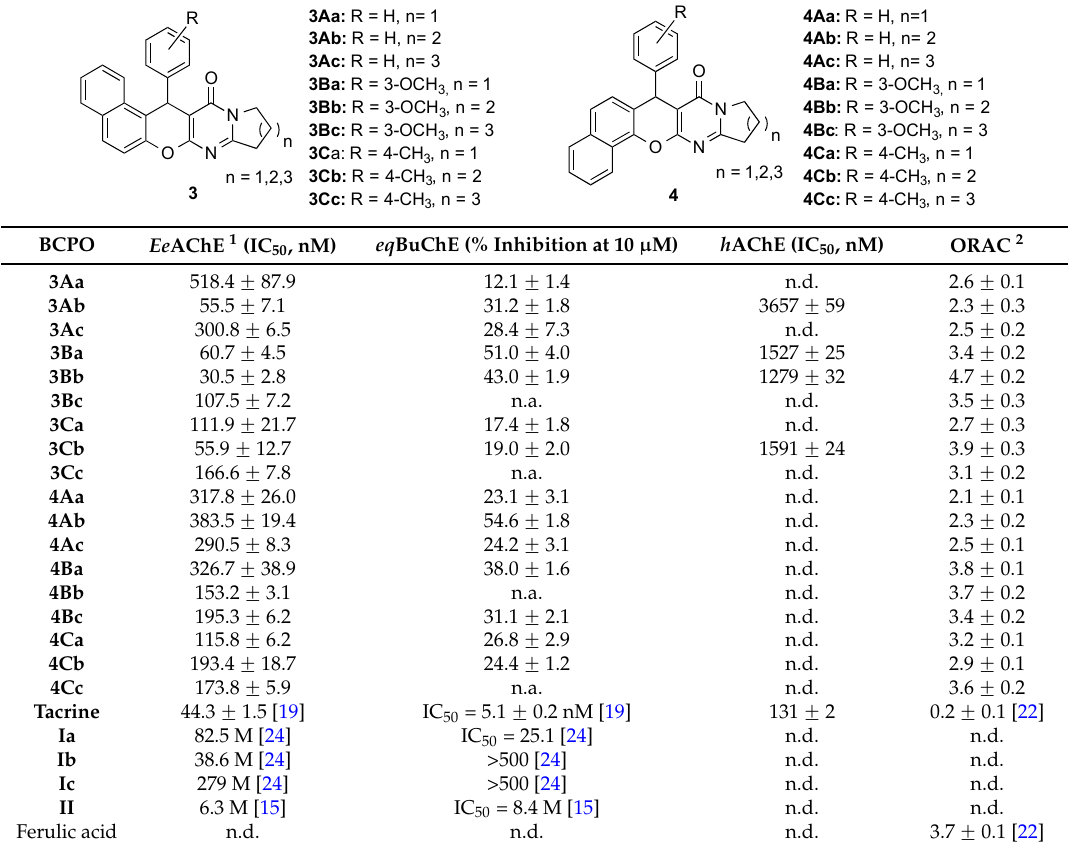
Table 1. Inhibitions of Ee AChE, eq BuChE, h AChE and ORAC-FL values for compounds 3 and 4 .